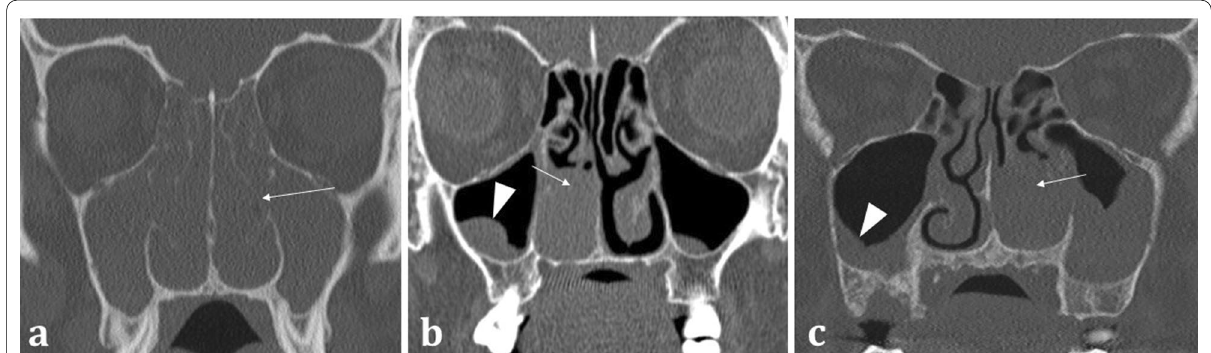
Fig. 4 Coronal bone window CT images of three different patients with sinonasal disease: 51-year-old female with 4-year history of nasal congestive symptoms and anosmia diagnosed with sinusitis ( a ); 70-year-old female patient presenting with bloody nasal discharge and right nasal blockage diagnosed with sinonasal carcinoma ( b ); and 70-year-old female presenting with nasal congestion diagnosed with malignant melanoma ( c ). Pansinusitis with complete opacification of the paranasal sinuses ( a ). The bilateral nature of the disease is a sign of benignity whilst the rarefaction and thinning of the bony architecture (arrowed) suggests a more chronic process. Conversely unilateral opacification as demonstrated in ( b ) and ( c ) is suspicious for a malignant process. Notice the bony destruction of the inferior turbinate in both cases (arrowed in b and c ), which can be difficult to discern from rarefaction (arrowed, a ); however, this must be assessed in the context of unilateral disease. The imaging appearances in ( b ) and ( c ) are strikingly similar on both CT and MRI (not shown) and were only distinguishable on histology, which confirmed sinonasal squamous cell carcinoma ( b ) and malignant melanoma ( c ). Incidental note is made of bilateral maxillary sinus mucus retention cysts ( b ), identifiable by their rounded, convex contour, and fluid density (arrowhead, b ), in contrast to the concave maxillary mucosal thickening (arrowhead, c